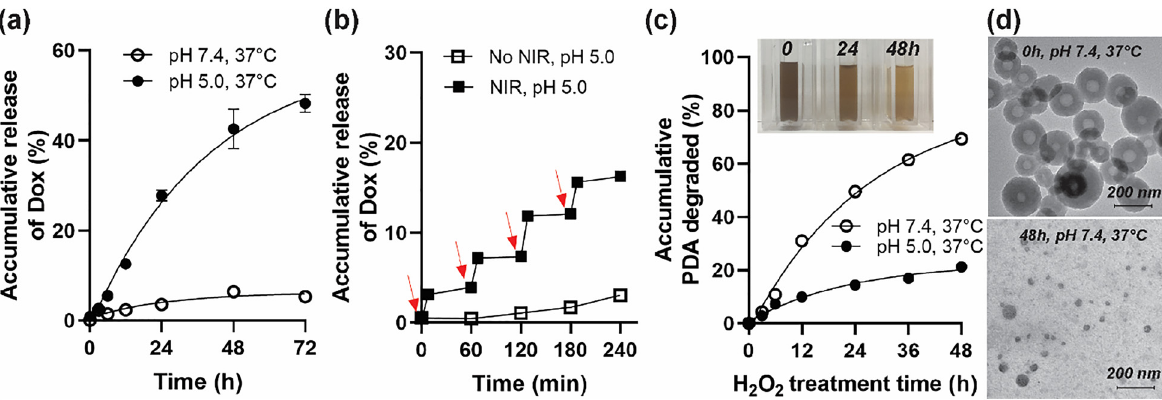
Figure 2: Release characteristics of DCP-F NPs. Dox release profile in response to (a) pH and (b) NIR irradiation (1 W/cm 2 , 8 min) at room temperature; (c) degradation, and (d) TEM images of PDA in 10 mM H 2 O 2 at pH 7.4 and 5.0,